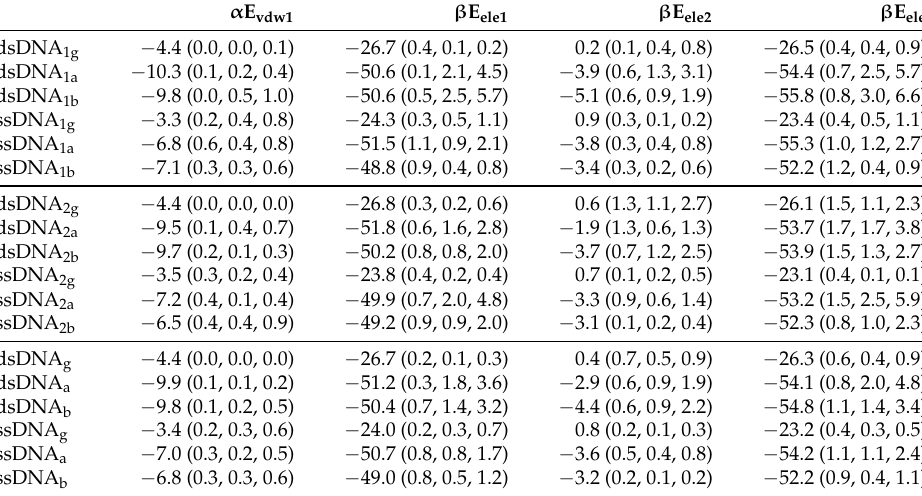
Table 1. Scaled non-bonded interaction energies (kcal/mol). a